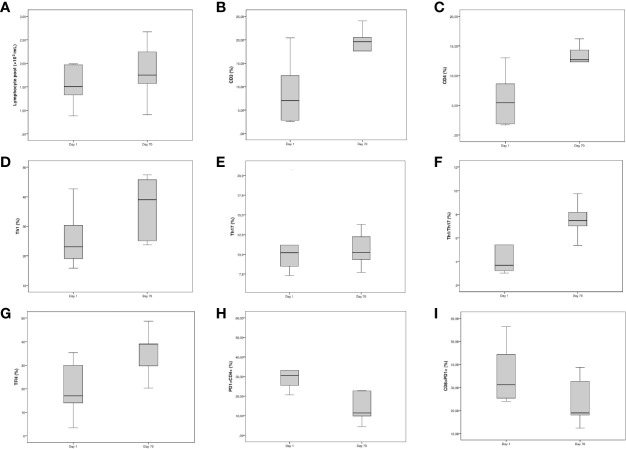
Longitudinal study of the fraction of Th populations in peripheral blood of non-intensive care unit (ICU) hospitalized patients. The line within the box represents the median, the top and the bottom of the box represents the 75th and 25th percentiles, respectively. (A–C) Boxplots for [left] lymphocyte pool (×10−3/ml), [middle] CD3 (%) and [right] CD4 (%). (D–F) Boxplots for [left] Th1 (%), [middle] Th17 (%), and [right] Th1/Th17 (%). (G–I) Boxplots for [left] TFH (%), [middle] CD4+PD-1+ T cells, and [right] CD8+PD-1+ T cells.